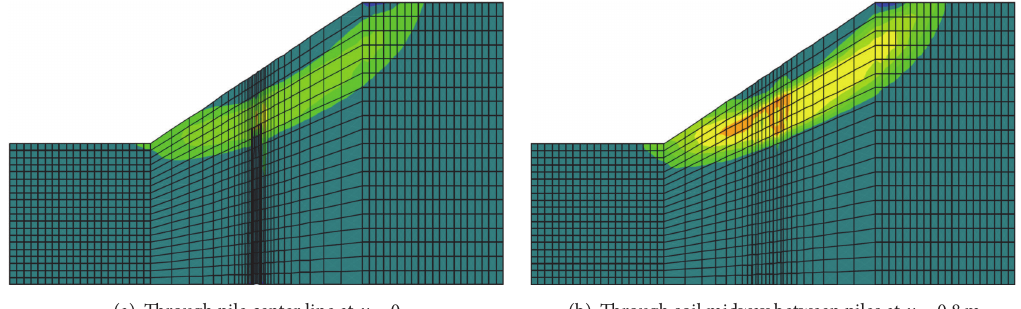
Figure 18: Failure mode of a slope with piles C = 0.88 at different sections.